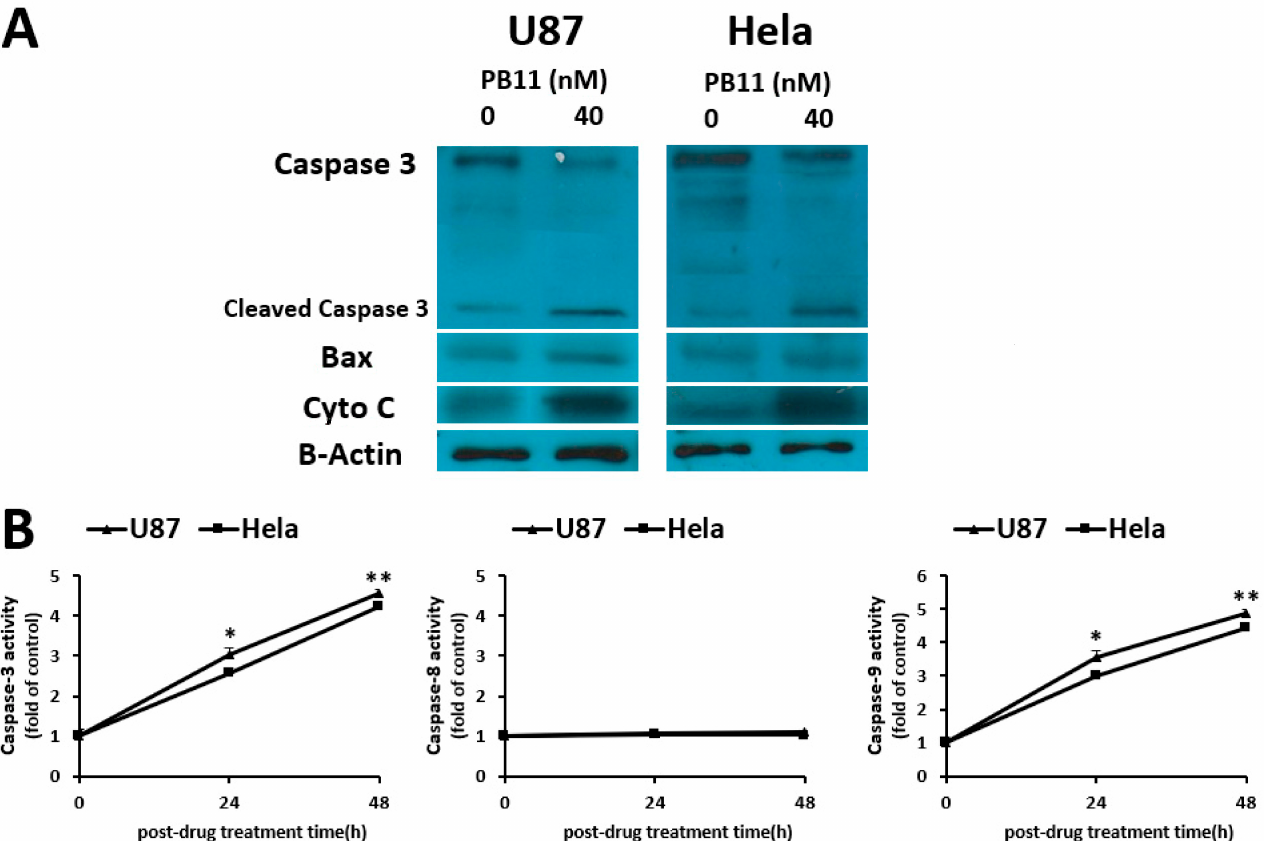
Figure 4. The increased levels of apoptosis markers in PB11-treated cells. ( A ): Western blot of apoptotic proteins. U87 and HeLa cells were grown in 6-well culture plates with 40 nM PB11. After 48 h, cell lysates were prepared and blotted with antibodies against caspase-3, Bax, and cytochrome C. β -actin was used as loading control. ( B ): Comparison of caspase-3, -8, and -9 activities. Cells were treated with 40 nM PB11. Cell lysates were prepared after 24 h and 48 h. The caspase activities were assessed using commercial kits. All data are expressed as mean ± SEM. Statistical significance was analyzed with the two-paired Student’s t -test; ns = p > 0.05, * = p < 0.05, ** = p <